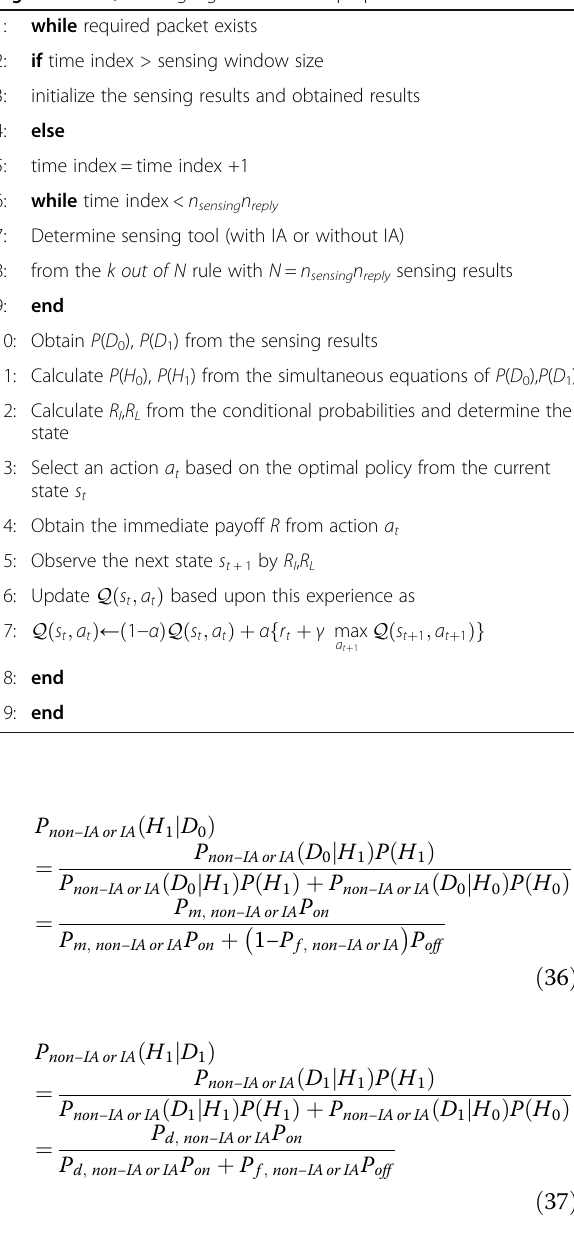
Table 1 Q-learning algorithm for the proposed scheme Algorithm 1 Q-learning algorithm for the proposed